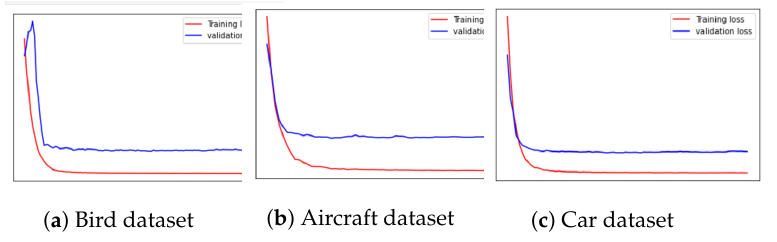
Figure 12. Training and validation loss of proposed classifiers using different datasets. Table 7. Performance of proposed method on various datasets with different child